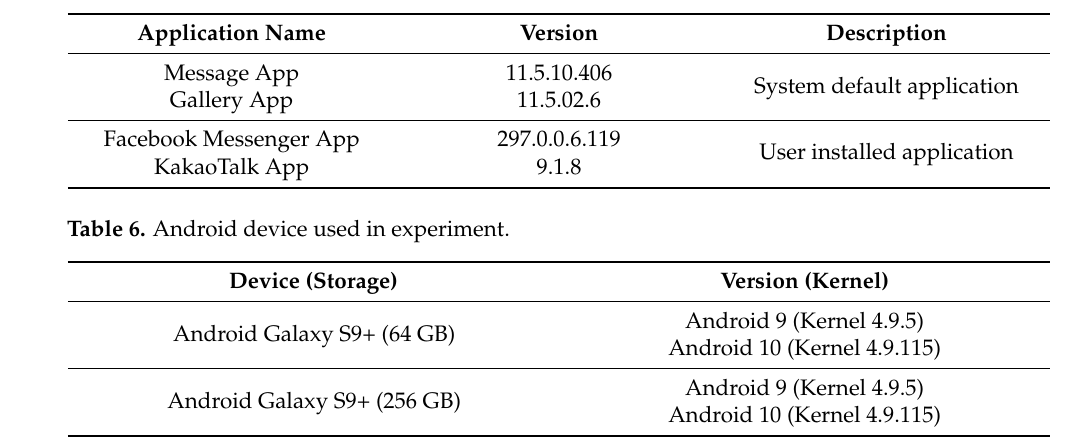
Table 5. Android application used in experiment.